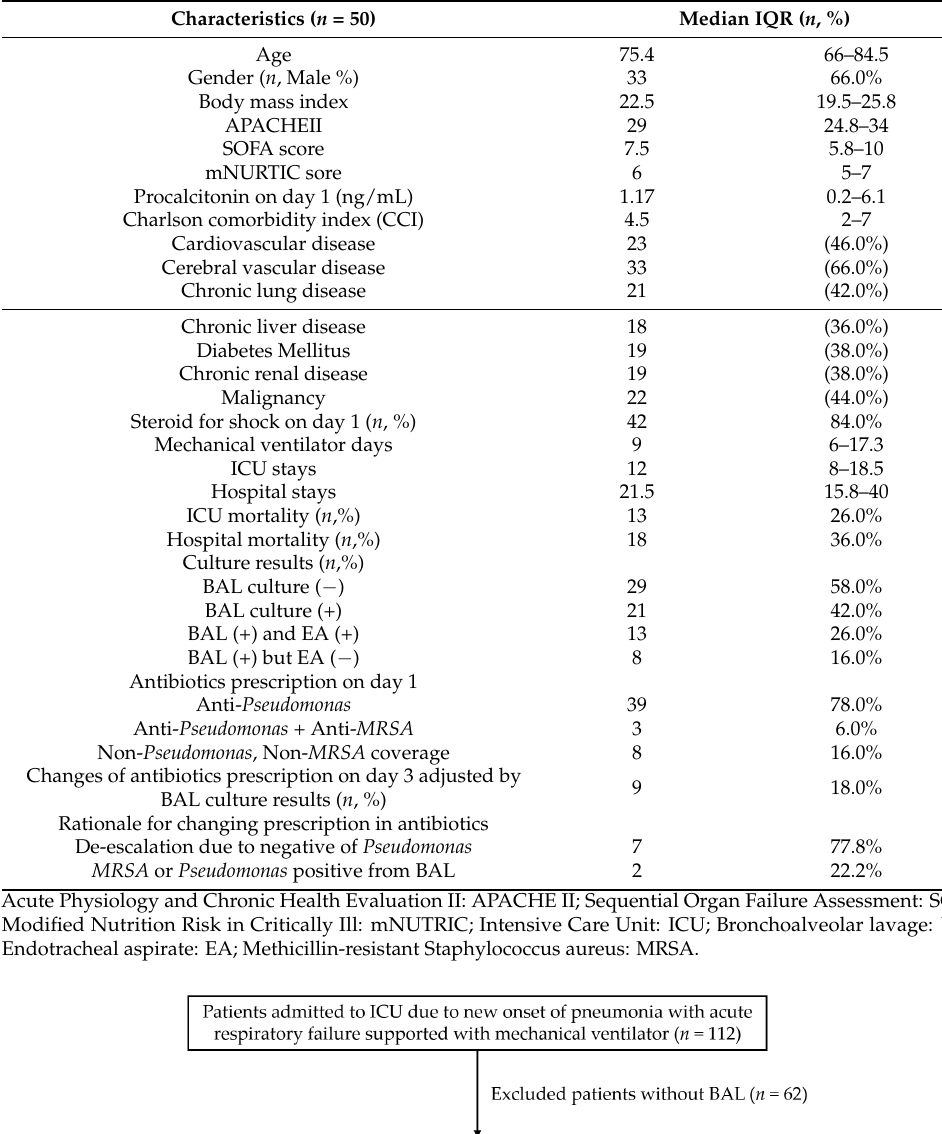
Table 1. Demographic characteristics, severity scores, comorbidities, and clinical outcomes of all pneumonia patients undergoing bronchoalveolar lavage (BAL) in the intensive care unit ( n = 50).